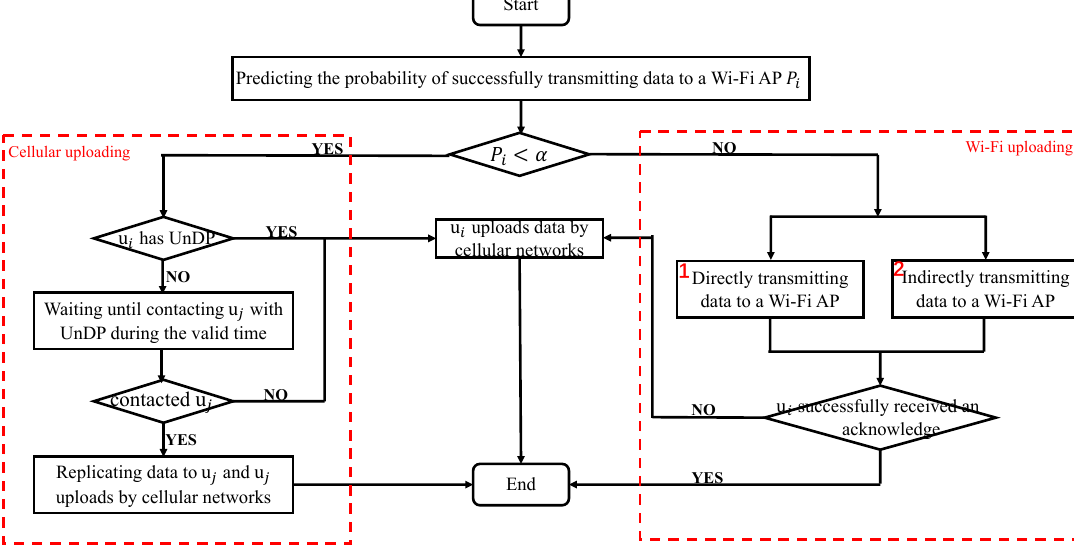
Figure 2. The proposed Intelligent Data Uploading Selection Mechanism